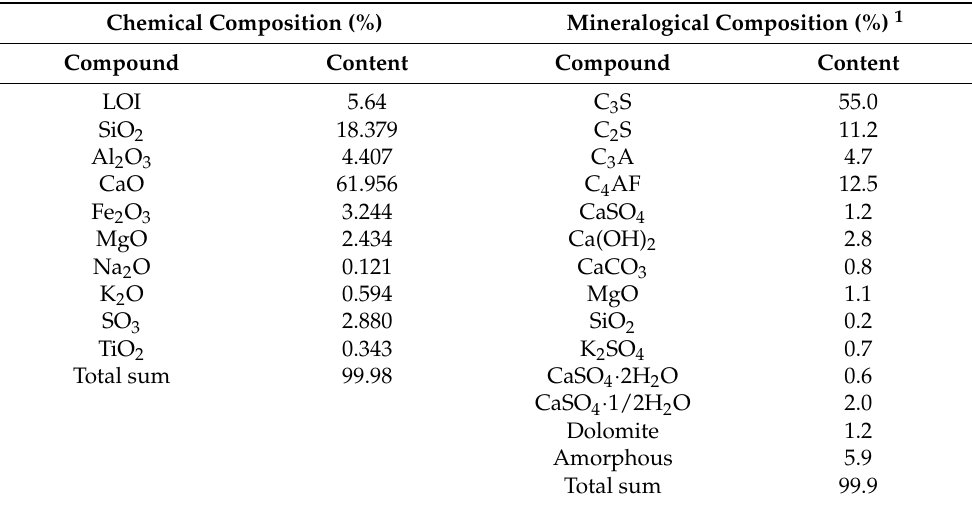
Table 1. Chemical and mineralogical compositions of the cement.